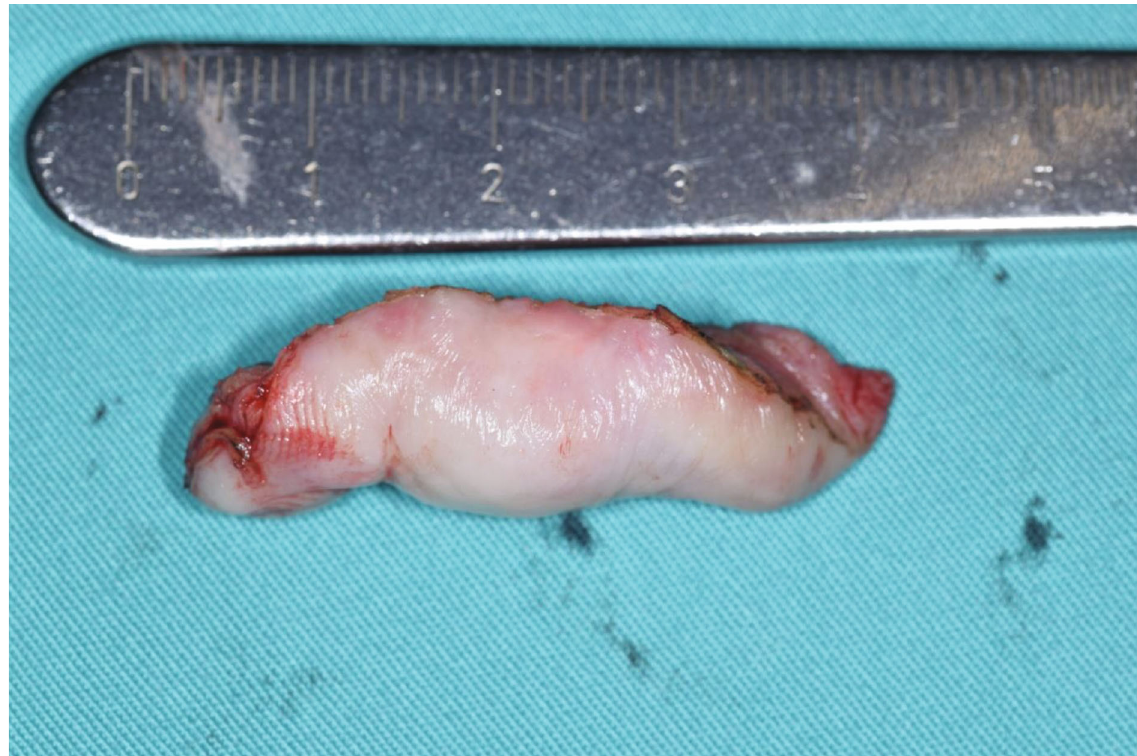
Figure 6: Ductile formation specimen after surgical excision.